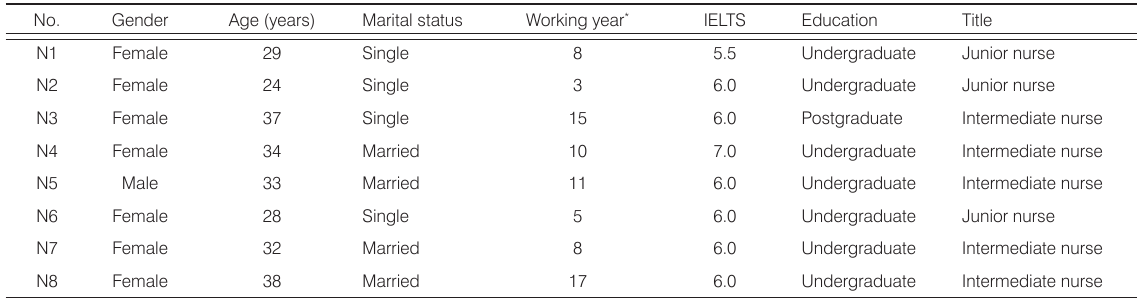
Table 1. Characteristics of participants ( N =